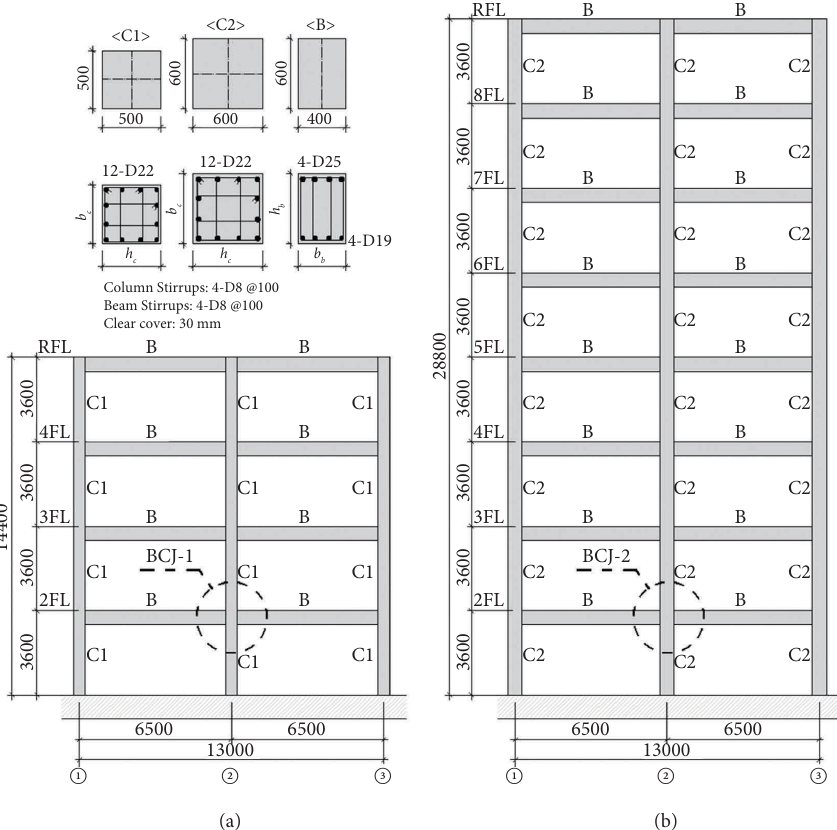
Figure 4: Geometry and member dimensions (mm) for the four- and eight-story frames. (a) A four-story frame (PF4). (b) An eight-story frame